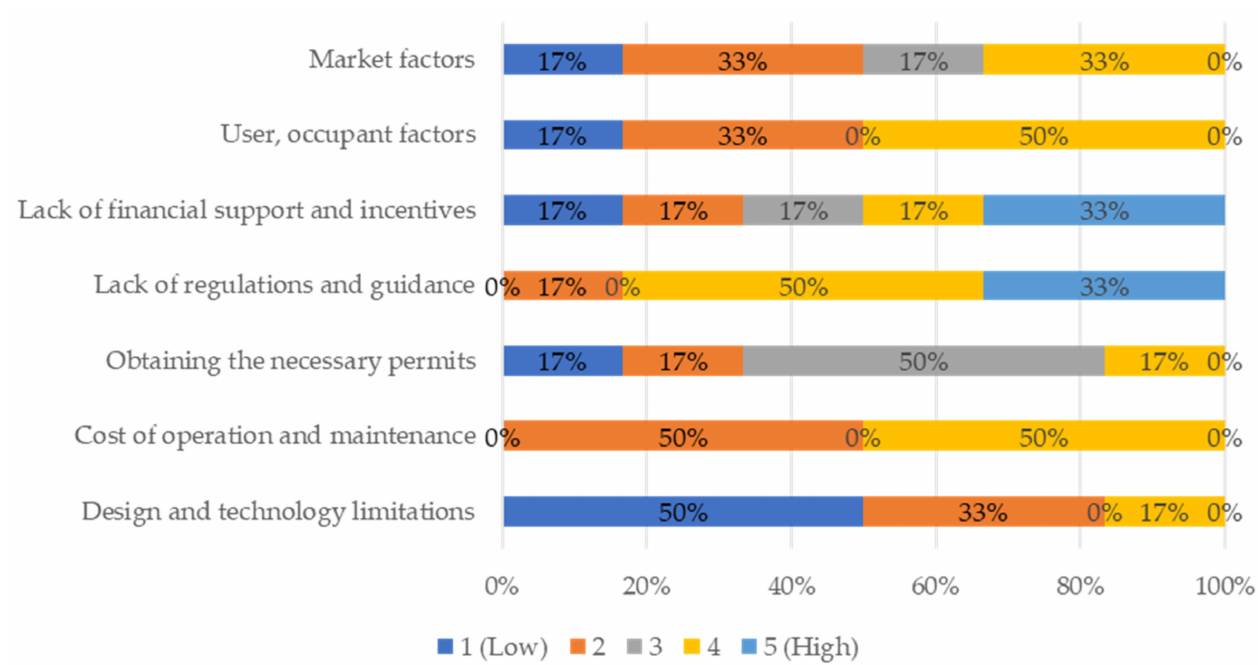
Figure 2. Participants’ rankings of the barriers to implementing the circular water/water reuse solutions in the